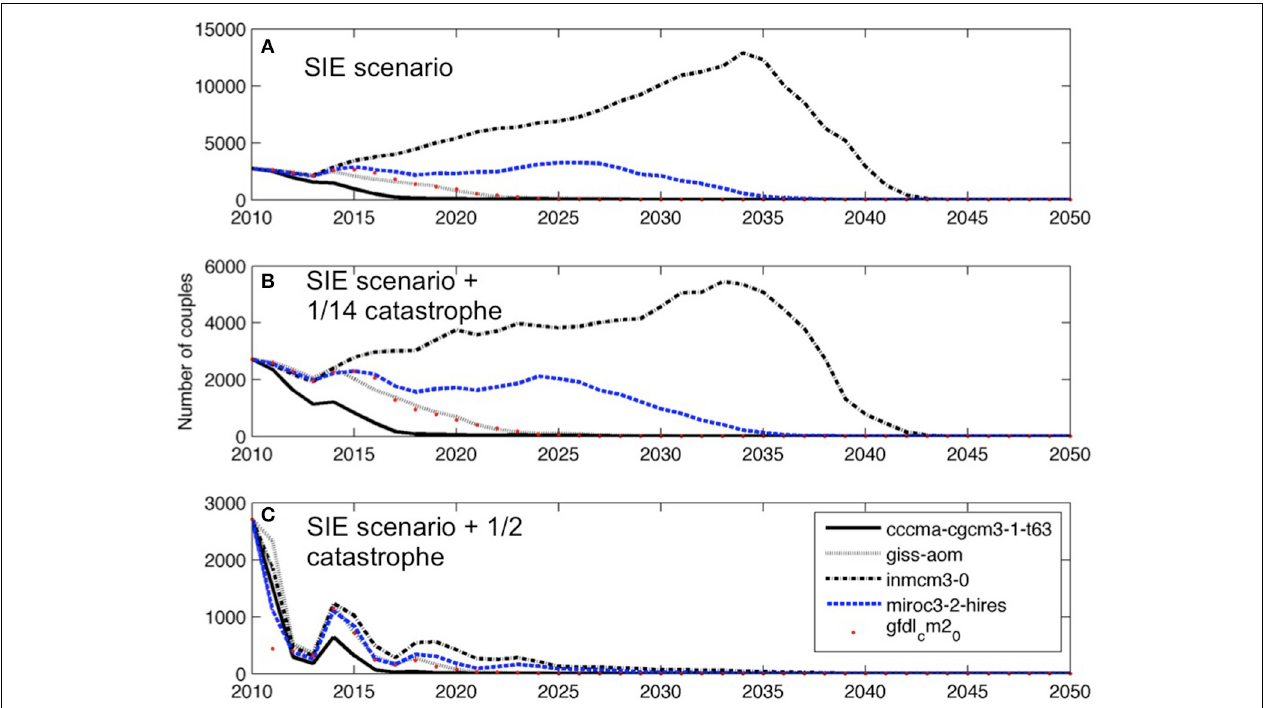
FIGURE 7 | Projections of the Adélie penguin population at Edmonson Point based on stochastic sea ice extent anomalies forecasts from five AOGCMs (A), considering a catastrophic weather event at breeding with